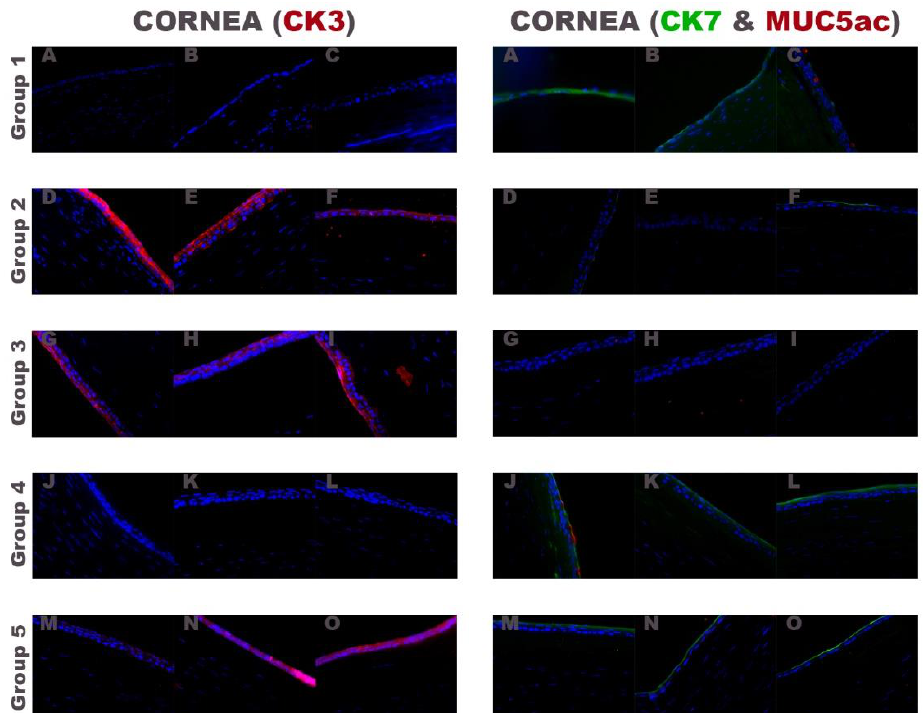
Figure 6. Immunofluorescence analysis of the central cornea with a CK3 positive (in red) multilayered corneal epithelium (left) or a CK7 positive (in green) conjunctival epithelium with or without the presence of MUC5ac positive (in red) cells (right). Group 1: only medical treatment (control group), Group 2: fibrin-PRGF membrane cultured with autologous rabbit LEPCs, Group 3: fibrin-PRGF membrane cultured with heterologous rabbit LEPCs, Group 4: fibrin-PRGF membrane SLET and Group 5: fibrin-PRGF membrane without rabbit cultured LEPCs. 400×. PRGF: Plasma Rich in Growth Factors; LEPCs: Limbal Epithelial Progenitor Cells; SLET: Simple Limbal Epithelial Transplantation.